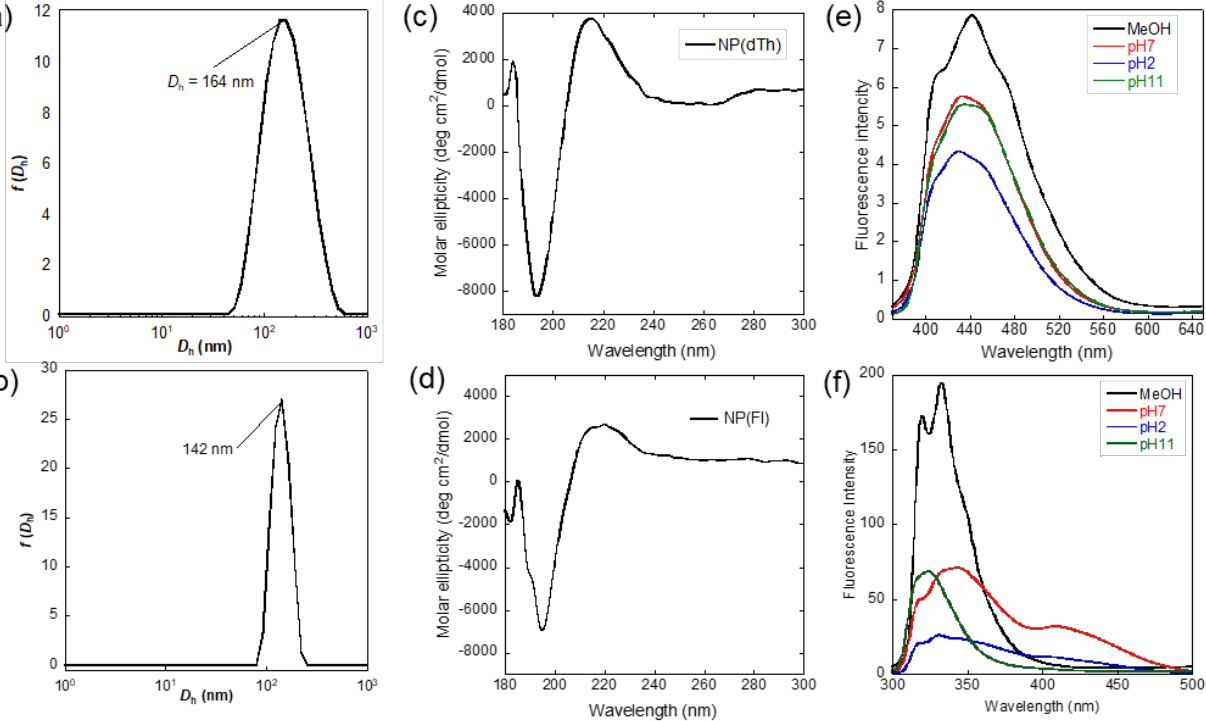
Figure 1. DLS traces of ( a ) NP(dTh) and ( b ) NP(Fl) in CH 3 OH (conc. = 2.0 mg/mL), CD spectra of ( c ) NP(dTh) and ( d ) NP(Fl) in H 2 O (conc. = 0.03 mg/mL), and fluorescence spectra of ( e ) NP(dTh) in CH 3 OH and H 2 O (conc. = 1.0 mg/mL) and ( f ) NP(Fl) in CH 3 OH (conc. = 0.001 mg/mL) and H 2 O (conc. = 0.01 mg/mL).